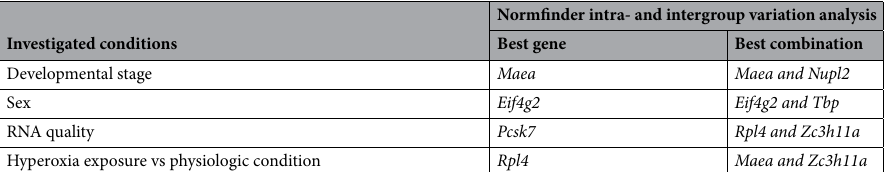
Table 4. Reliable reference genes identified by Normfinder intra- and intergroup variation analysis. The Normfinder intra- and intergroup variation analysis showed comparable results as the stability ranking analysis by Normfinder. cf. Fig.